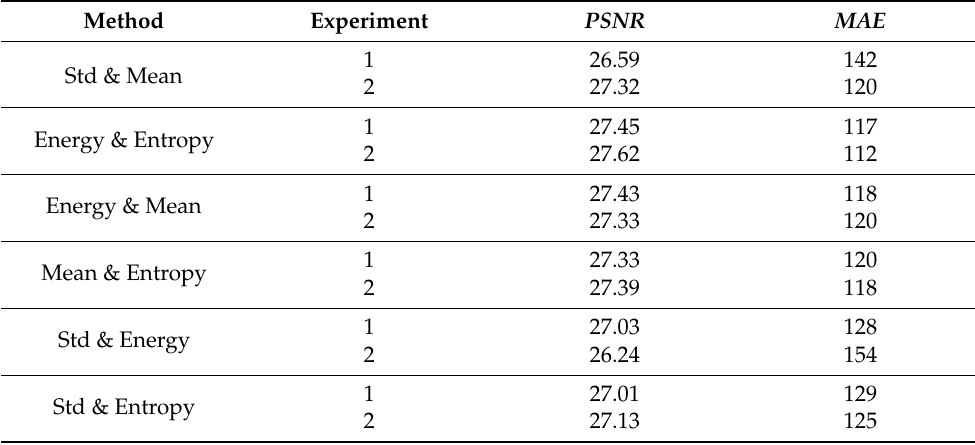
Table 3. Using Statistical Features Extracted from Image Histogram.